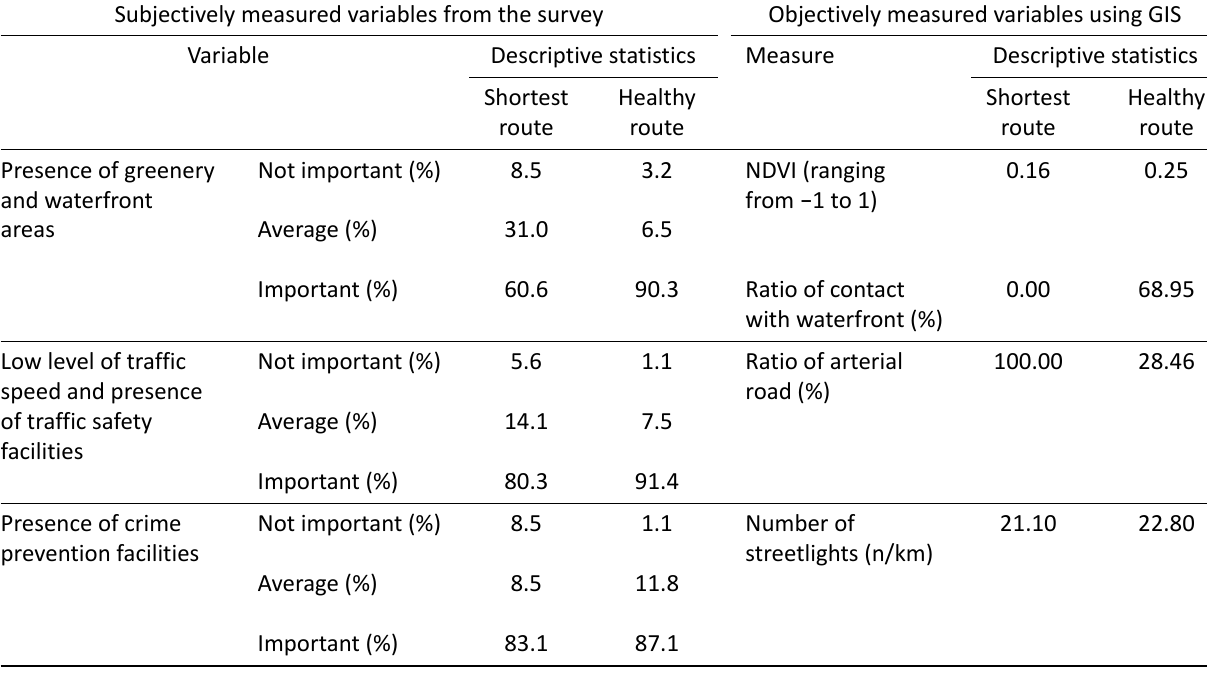
Table 2. Comparison of subjectively and objectively measured environmental conditions between the shortest route and healthy route